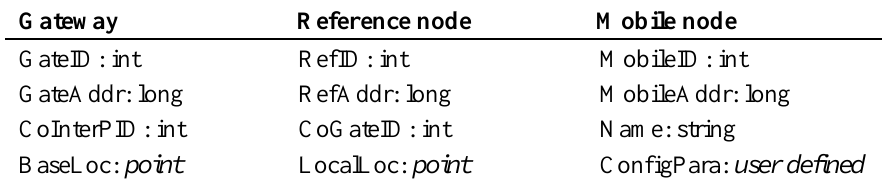
Table 2. Gateway, reference node and mobile node data structure.